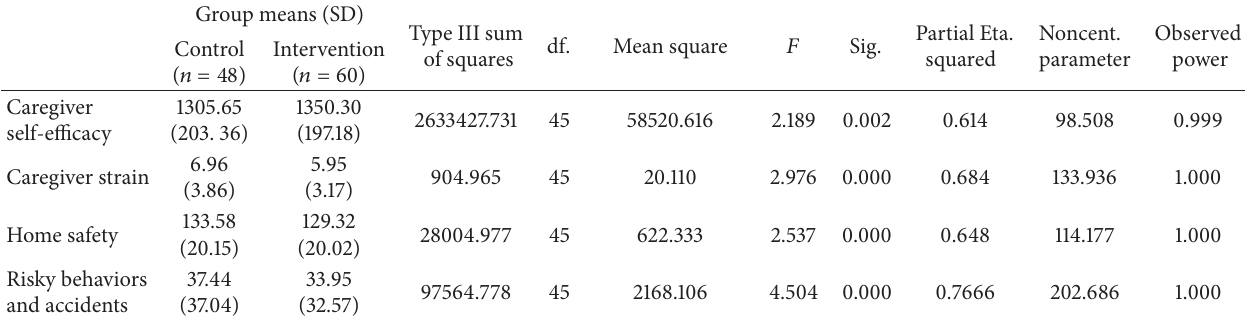
Table 3: Corrected model MANCOVA: tests of between-subjects effects ∗ .